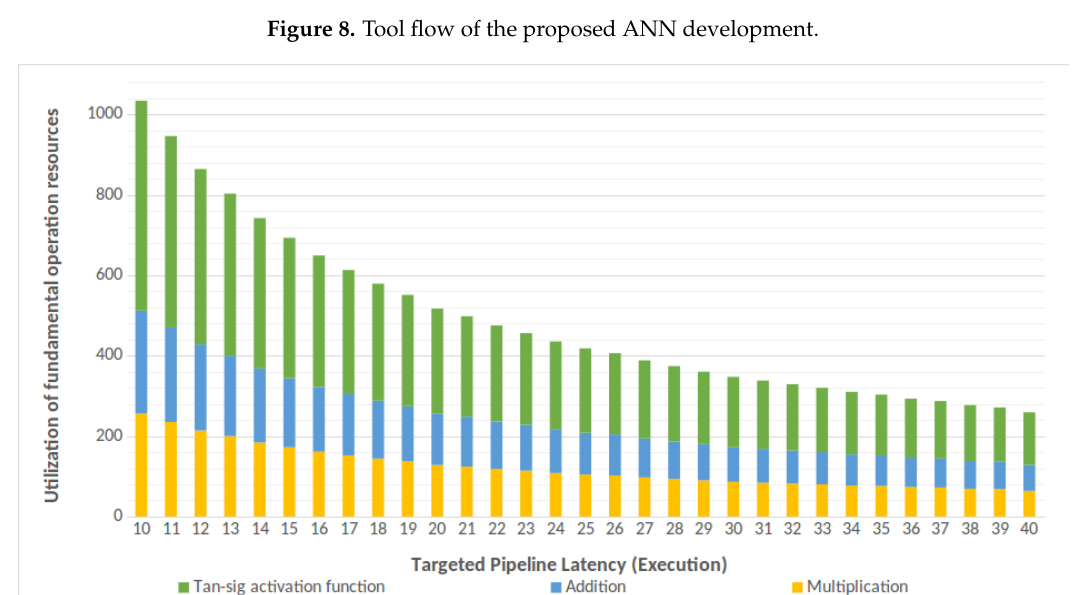
Figure 9. “Elementary layer” resource dependence on the targeted pipelining latency for a 17-40-30-20-4 FFNN topology [31]. The normalization layers are not displayed because their usage varies minimally (1–2